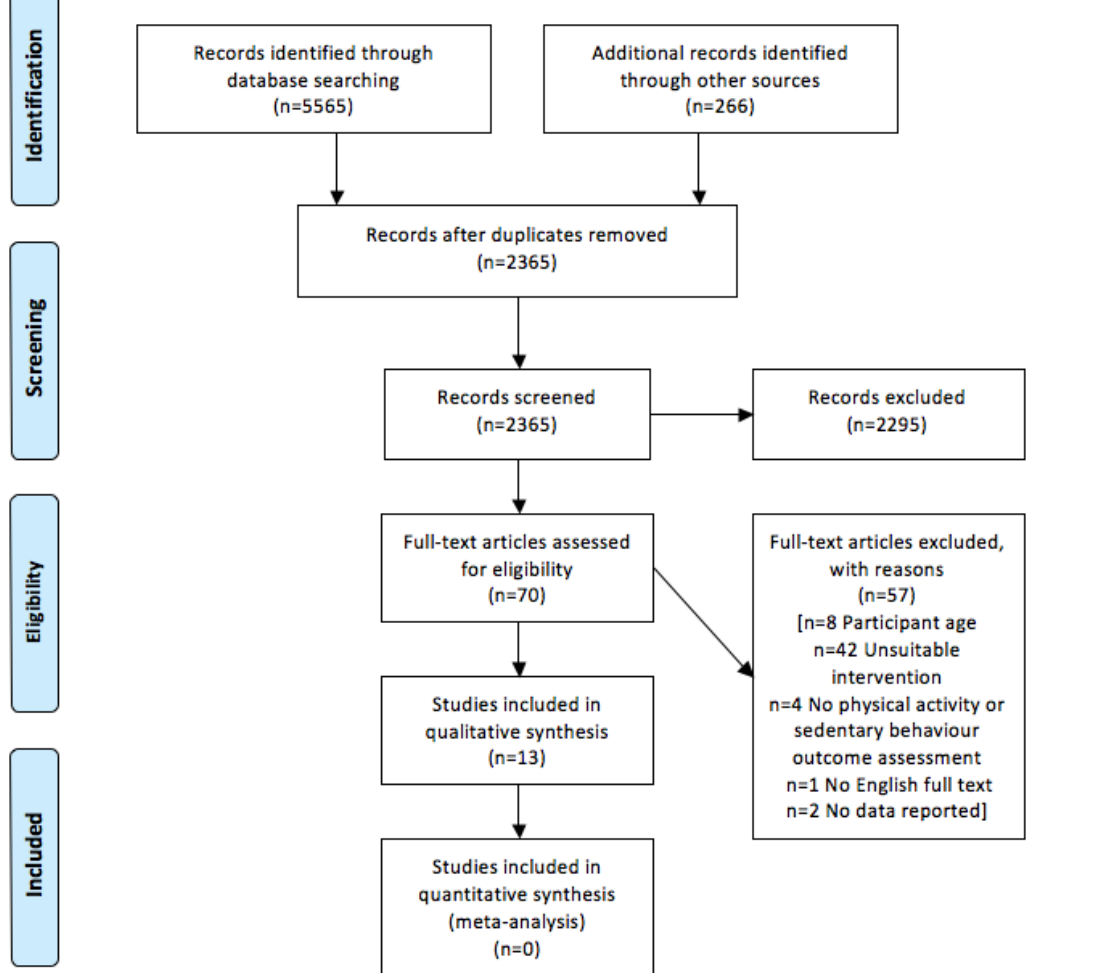
Figure 1. Literature search flow